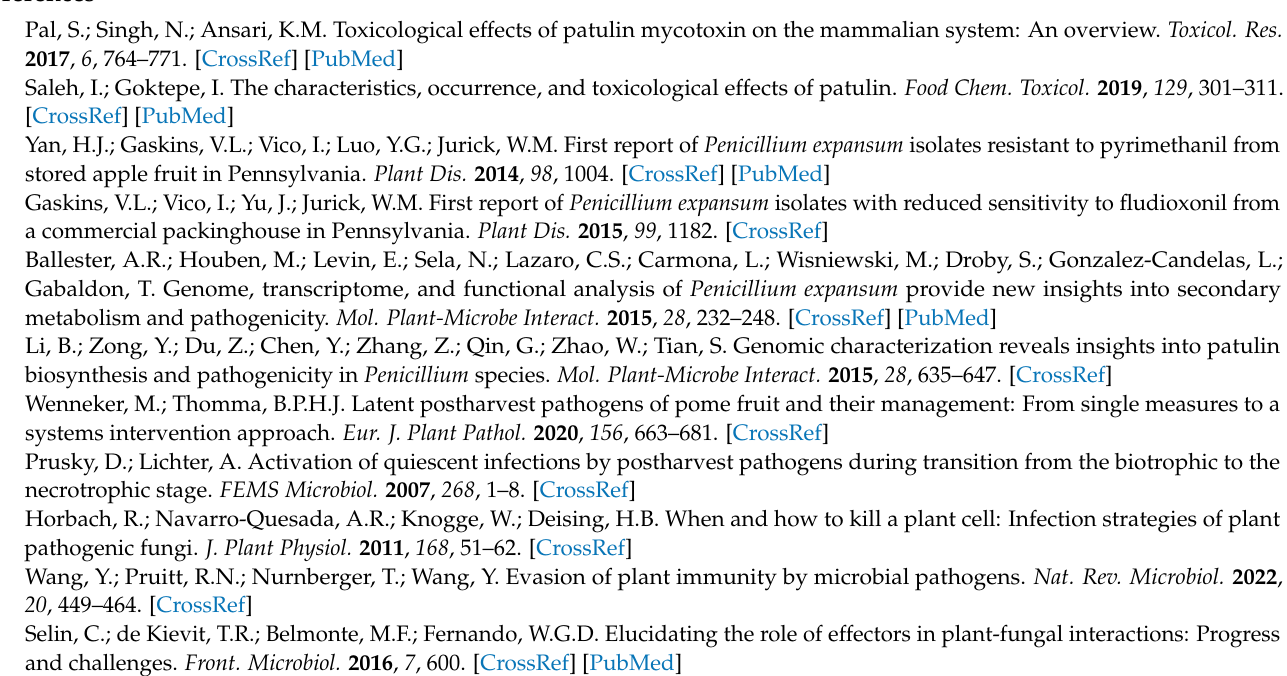
(b) Amplification of upstream, downstream and hyg fragments. (c) Fusion fragment obtained by overlap PCR amplification. (d) Verification of ∆ Peclg by PCR amplification using in and out primer pairs; Table S1: Primers used in qRT-PCR; Table S2: Summary of the RNA-Seq data and the reads mapped to P. expansum genome; Table S3: Differentially expressed genes in P. expansum at 6 and 9 hai; Table S4: List of the predicted effector protein genes in P. expansum at 6 and 9 hai. Author Contributions: Conceptualization, X.Z. and Y.W.; methodology, W.G. and X.X.;